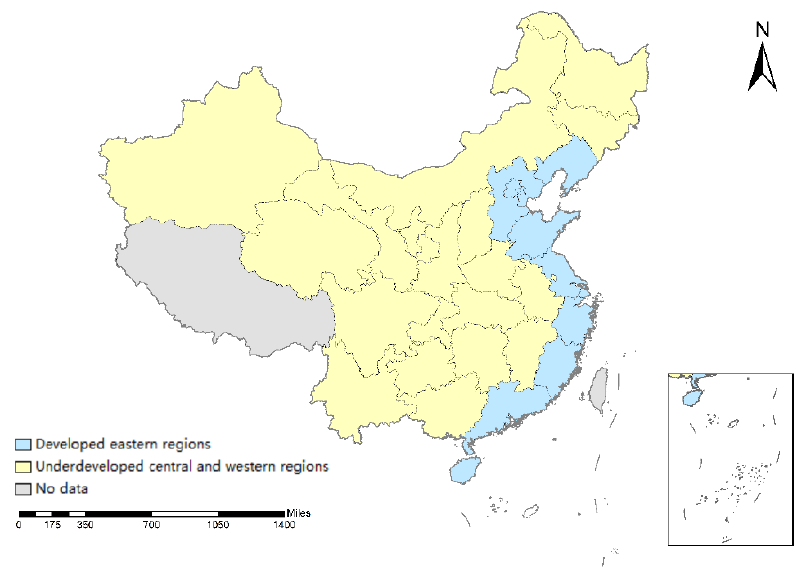
Figure 4. Regional division map of China (source: made by